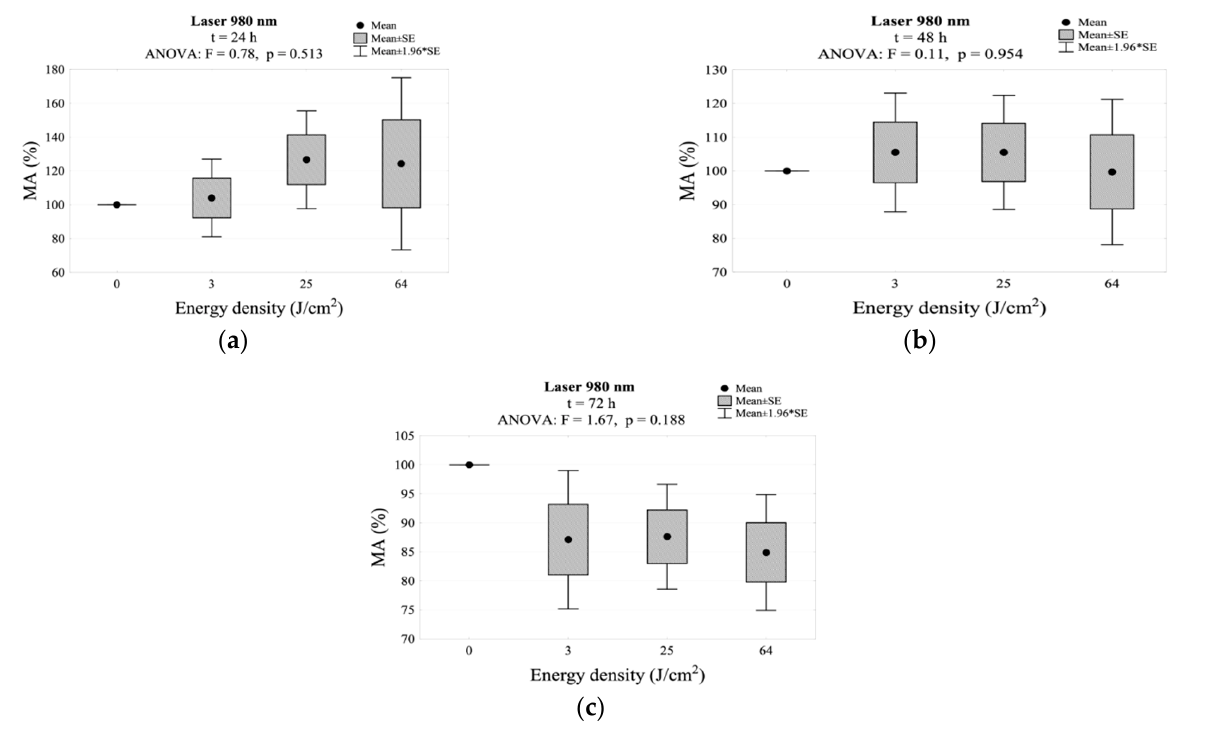
Figure 8. MA values measured: ( a ) 24 h, ( b ) 48 h, ( c ) 72 h after irradiation using the 980 nm laser.